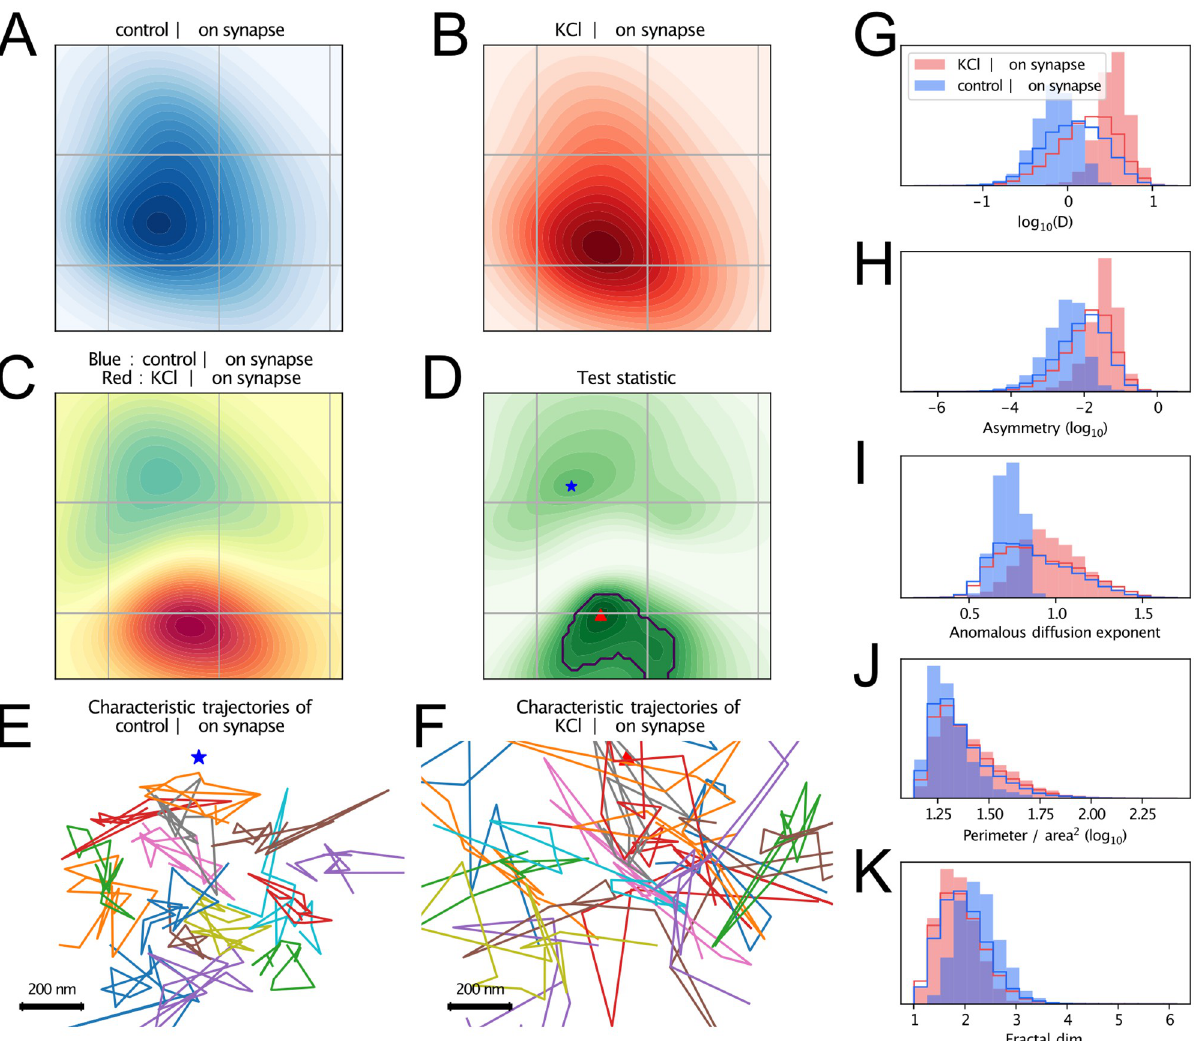
Fig 6. Most salient dynamics. ( C ) Witness function of the comparison of intra-synaptic trajectories, between the control (blue) and KCl (red) conditions. ( D ) Test statistic such as defined in [57], i.e. ratio of the square amplitude divided by the variance. The black contour indicates the “critical region” of the (KCl, on synapse) condition, i.e. the region of the latent space where this condition predominates and which is most responsible of the statistical difference. ( E ) and ( F ) Illustration, for each maximum of the test statistic, of its 16 closest trajectories. ( G-K ) Histograms of descriptive quantities, grouped by conditions. Outlined histograms correspond to the whole population of trajectories of a condition, while filled histograms correspond only to those located in the “critical” region of each condition (hence the better separation).